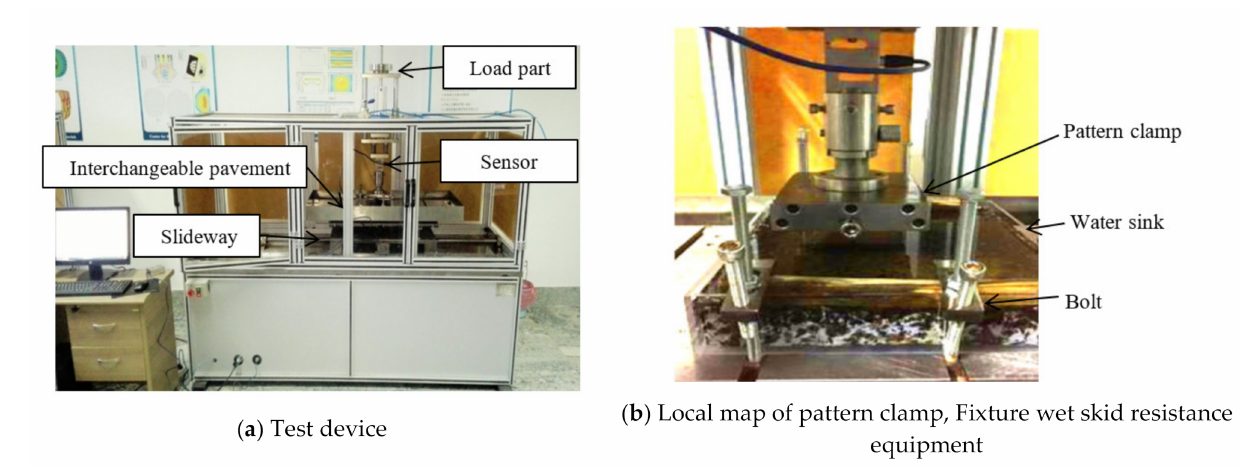
Figure 4. Wear test platform.